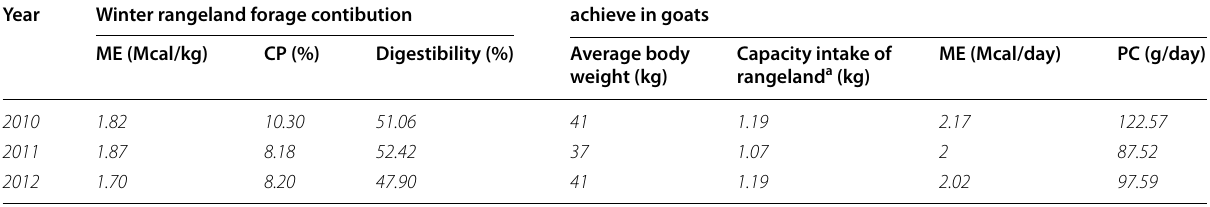
Table 5 Characteristics of the nutritional contribution of winter rangeland and requirement achieve in goats